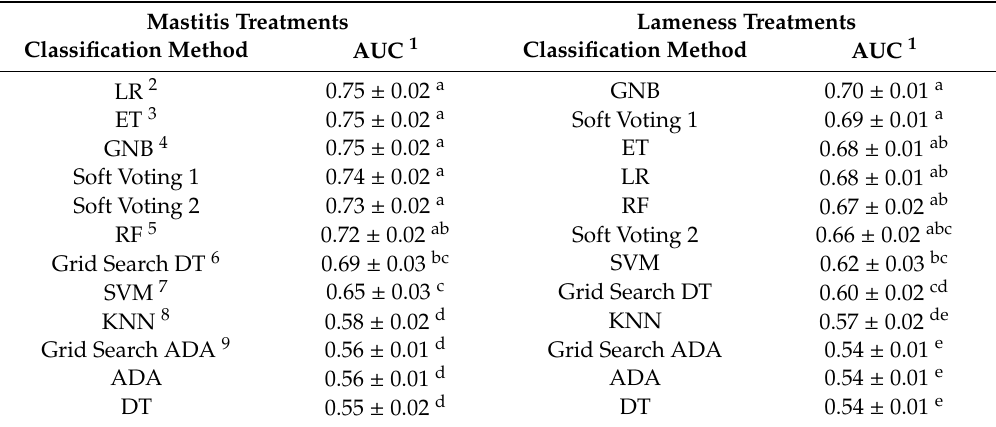
Table 6. Mean testing data AUC, Sensitivity, Block Sensitivity and Specificity ( ± 95%-CI) for each classification model, averaged over all sampling methods, for mastitis and lameness